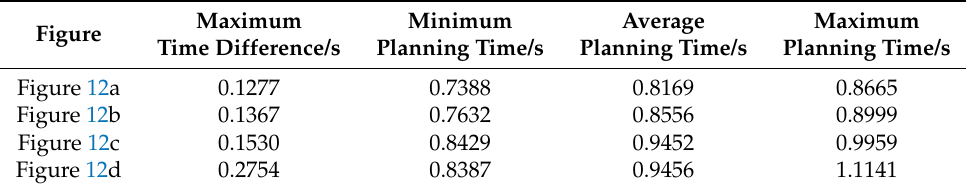
Table 4. Time data from 50 experiments for BS-RRT algorithms in common